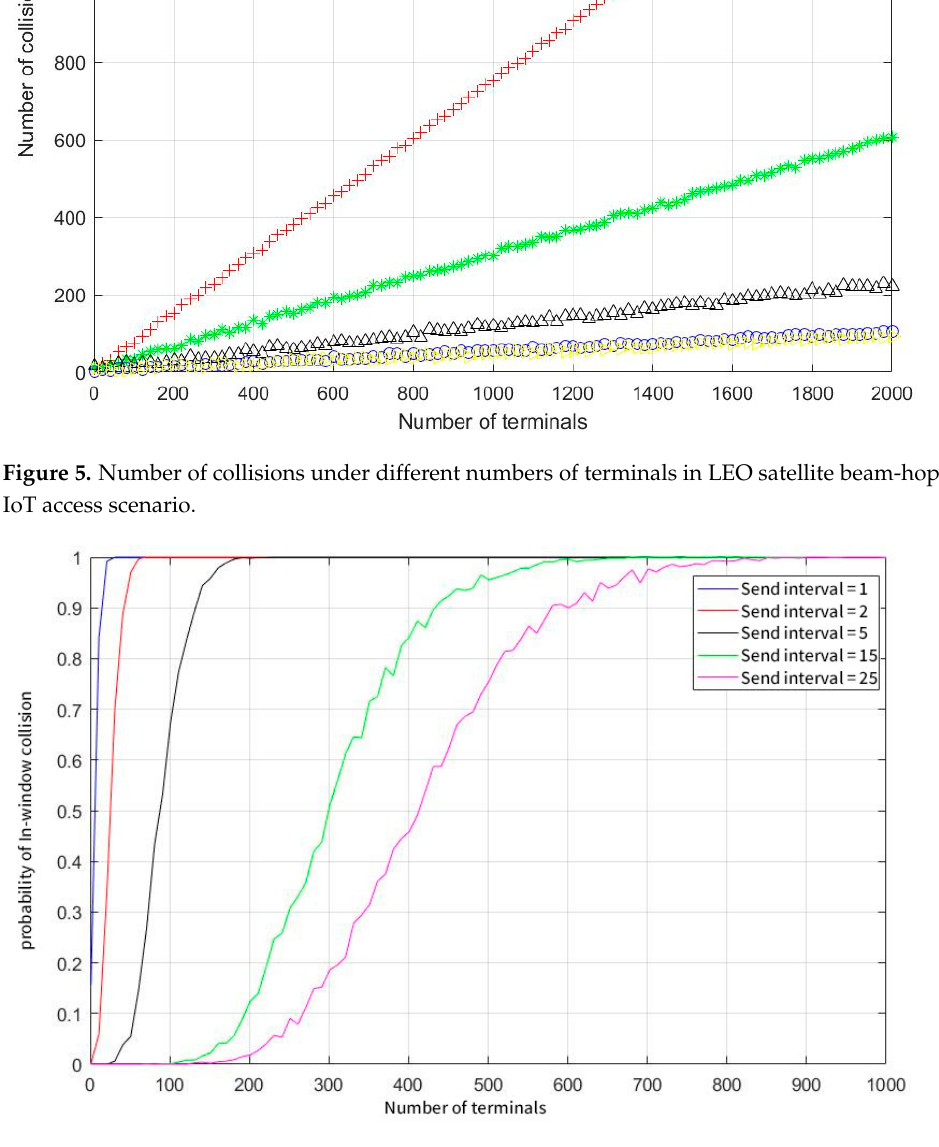
Figure 7. The probability of a window collision at concurrent demodulation thresholds equals 100. Figure 8 shows that when a user sends data every second, the transmission success rate drops sharply as the number of users increases, and when the parallel demodulation threshold is set to 200, the peak capacity of the system is only 250. Figure 9 illustrates that when the user’s sending probability is further reduced, the capacity of the system is greatly increased again after the user sends data once in 15 s. In this case, a concurrent demodulation number of 50 can also guarantee the conflict-free sending and receiving of nearly 1000 users, and the limit capacity is close to the maximum number of users in the system.